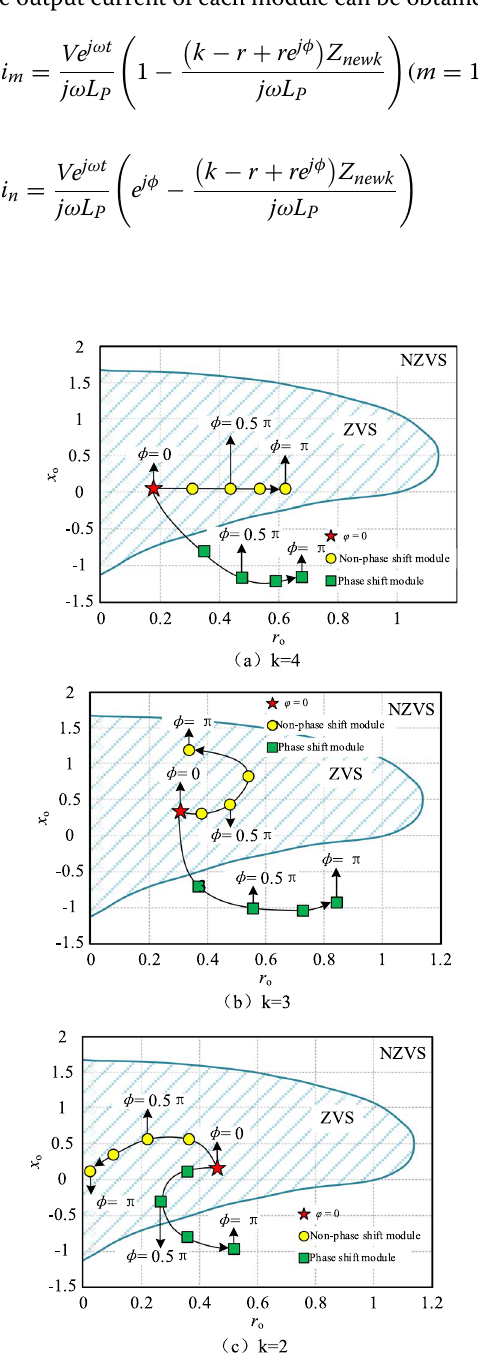
Fig. 9 Variation trends of equivalent impedance of non-phase shift module and phase shift module with different phase shift angles. a k 4, b k 3, c k = = =